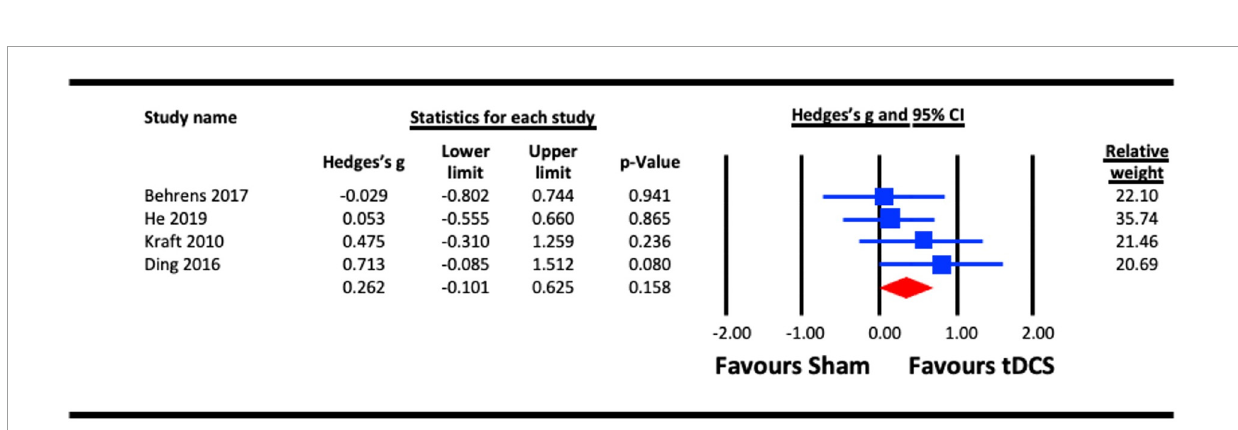
FIGURE3 Acute effect of anodal-transcranial direct current stimulation (a-tDCS) on contrast sensitivity.